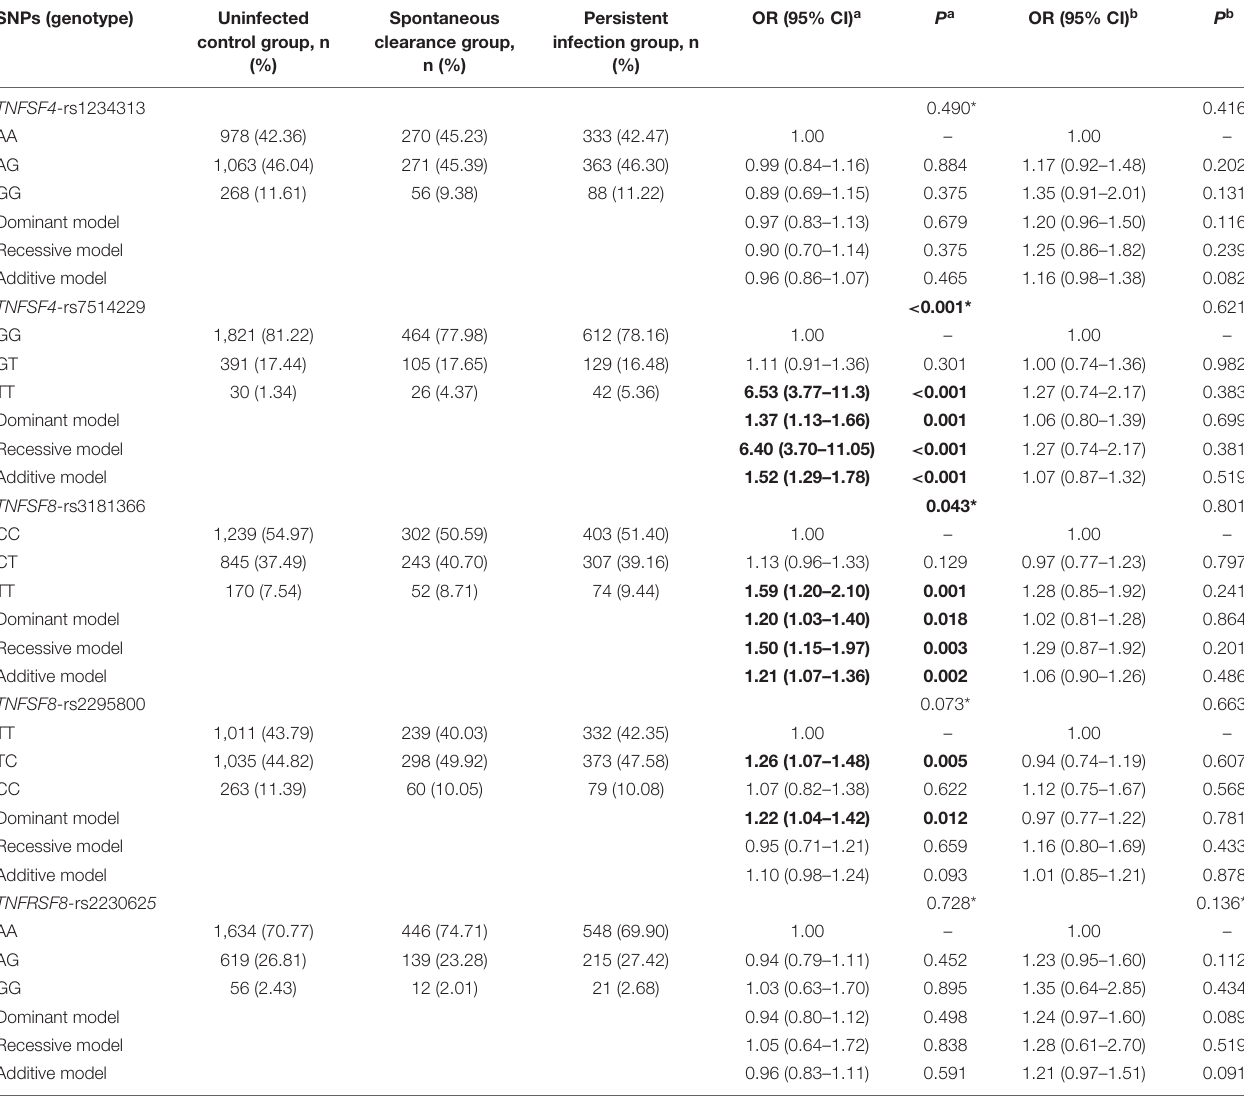
TABLE 2 | Distribution of TNFSF/TNFRSF genes among the uninfected control, spontaneous clearance, and persistent infection